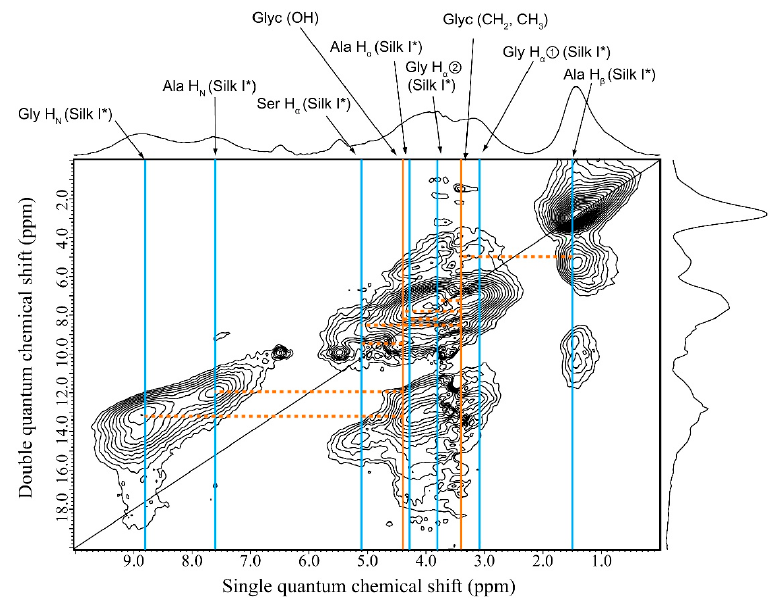
Figure 8. 1 H DQMAS NMR spectrum of Glyc (29 wt %)-blended SF film. The 1 H– 1 H correlation signals (broken lines) between the OH or CH 2 groups of Glyc ( orange ) and SF with Silk I* ( blue ) form are shown.